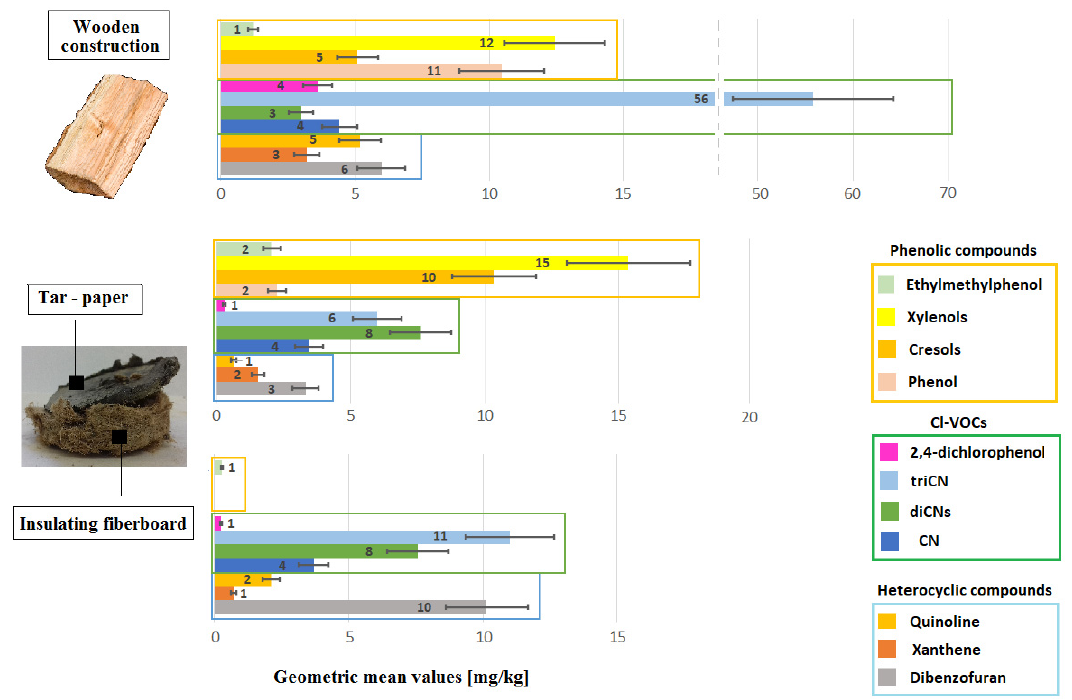
Figure 6. Emission of heterocyclic aromatic hydrocarbons, organochlorine derivatives, and phenolic compounds from samples of construction products taken from buildings intended for human habitation, where complaints about unacceptable hygienic conditions were raised.